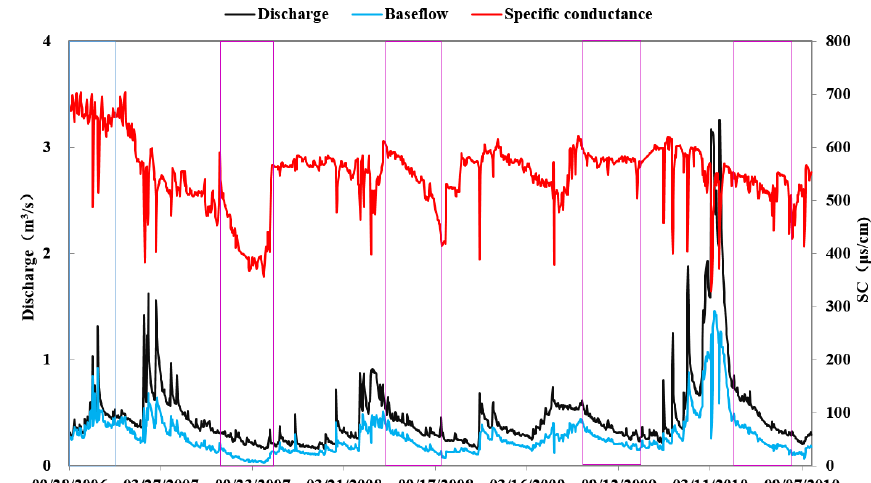
Figure 6. Temporal variation in discharge, specific conductance and baseflow for a typical site in the Mississippi River